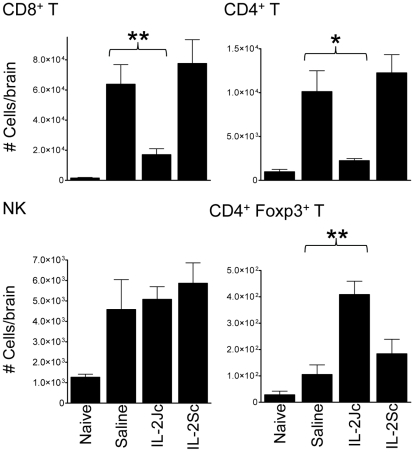
IL-2Jc blocks conventional T cell recruitment to the brain during ECM.Brain sequestered leukocytes from naïve, PbA-infected & saline treated, and PbA-infected, IL-2Jc or IL-2Sc-treated C57BL/6 mice (n = 5) were isolated on day 6 p.i., when control, infected mice were displaying ECM symptoms, and phenotyped by flow cytometry. Mann-Whitney: *p<0.05; **p<0.01. These data are representative of 3 independent experiments.